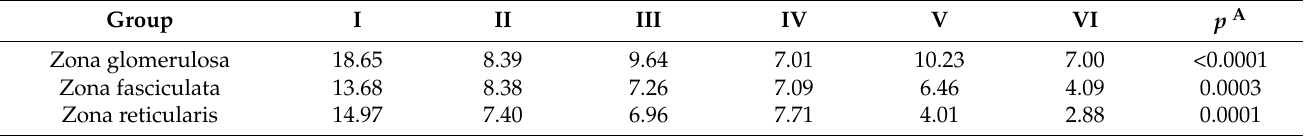
Table 5. The mean percentage of pyknotic nuclei.